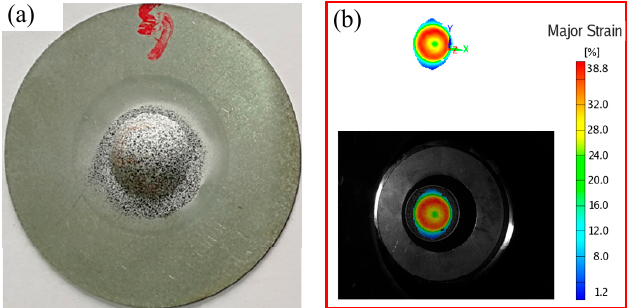
Figure 12. Strain measurement after white light scanning (blank holder force is 115 kN): ( a ) White light scanning sample, ( b ) Measurement results of major strain.